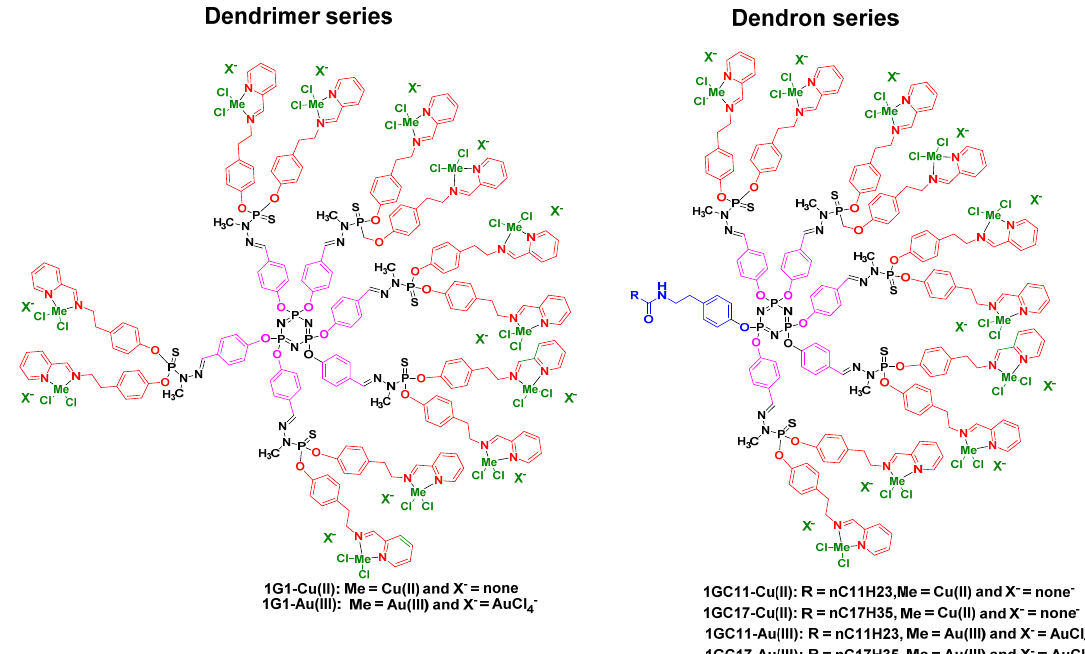
Au(III)-phosphorus dendrimers.